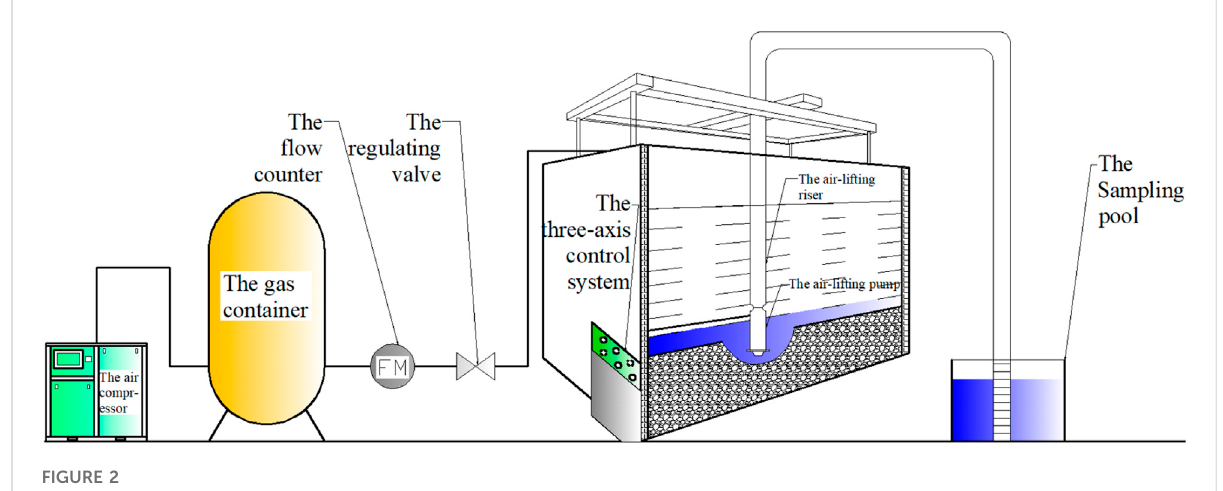
FIGURE 2 Schematic diagram of experimental